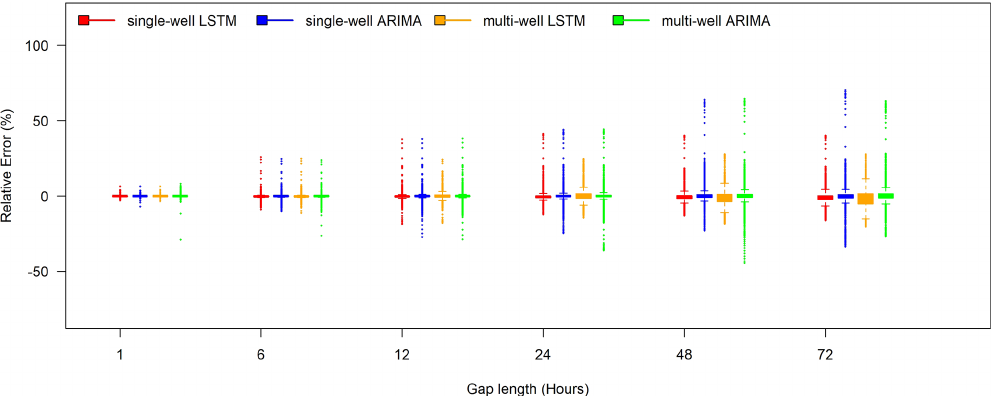
Figure 9. Comparing relative error performance between the best single-well LSTM models (well 1-1 – red), multi-well LSTM models (wells 1-1, 1-10A, and 1-16A – yellow), a single-well ARIMA model (blue), and a multi-well ARIMA model (green) for filling in various SpC gap lengths for well 1-1 during the test period (year